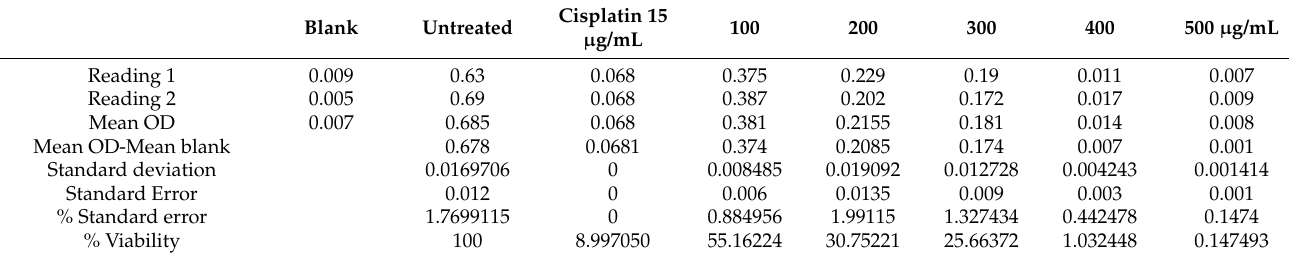
Table 6. Anticancer activity of C. limon